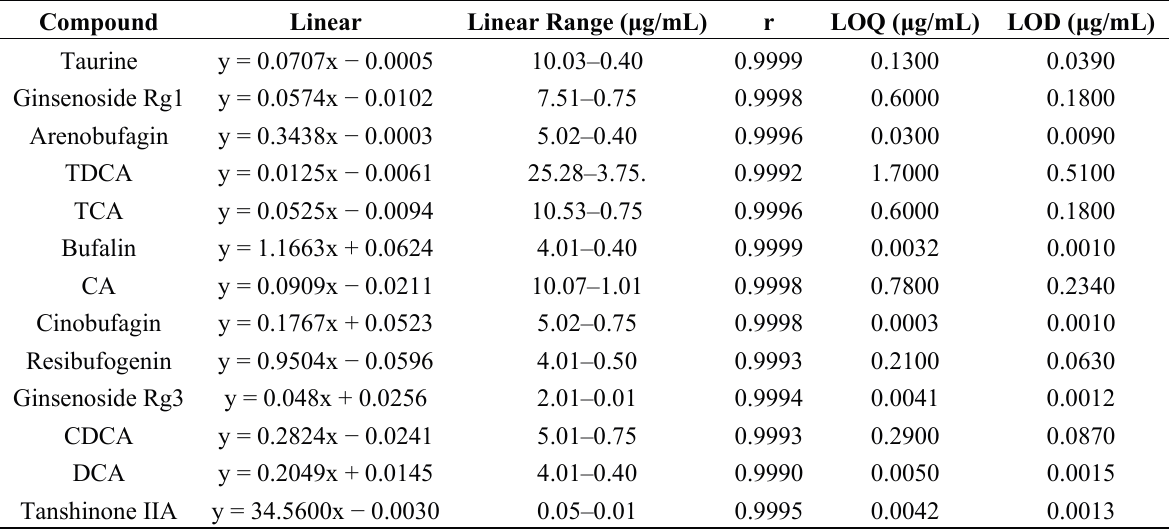
Table 2. Calibration curves, linear ranges, LOQ and LOD of 13 detected compounds ( n = 3).